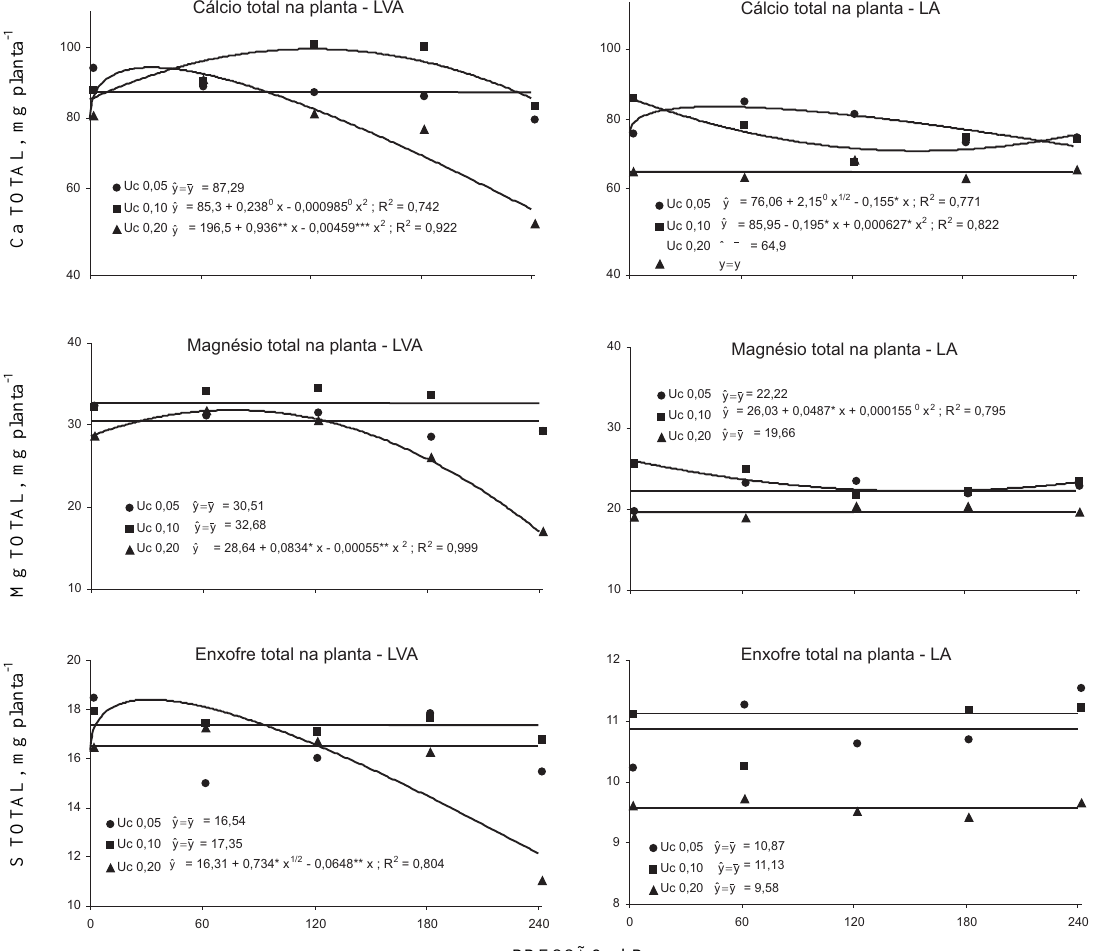
Figura 4. Conteúdos de cálcio, magnésio e enxofre na matéria seca total de eucalipto em dois Latossolos compactados com diferentes pressões e